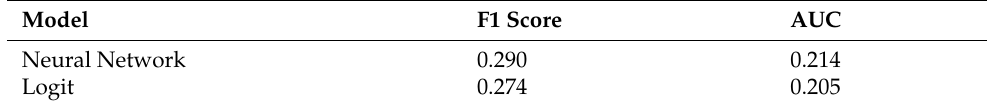
Table 7. Model comparison, F1 score